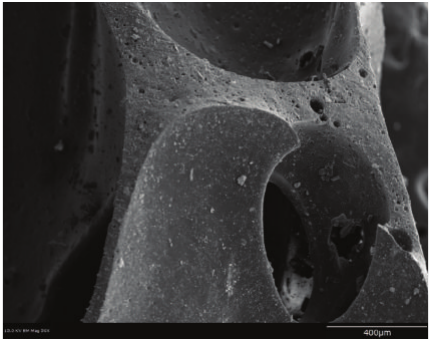
Figure 5: SEM image of polyurethane foam at 50x magnification.